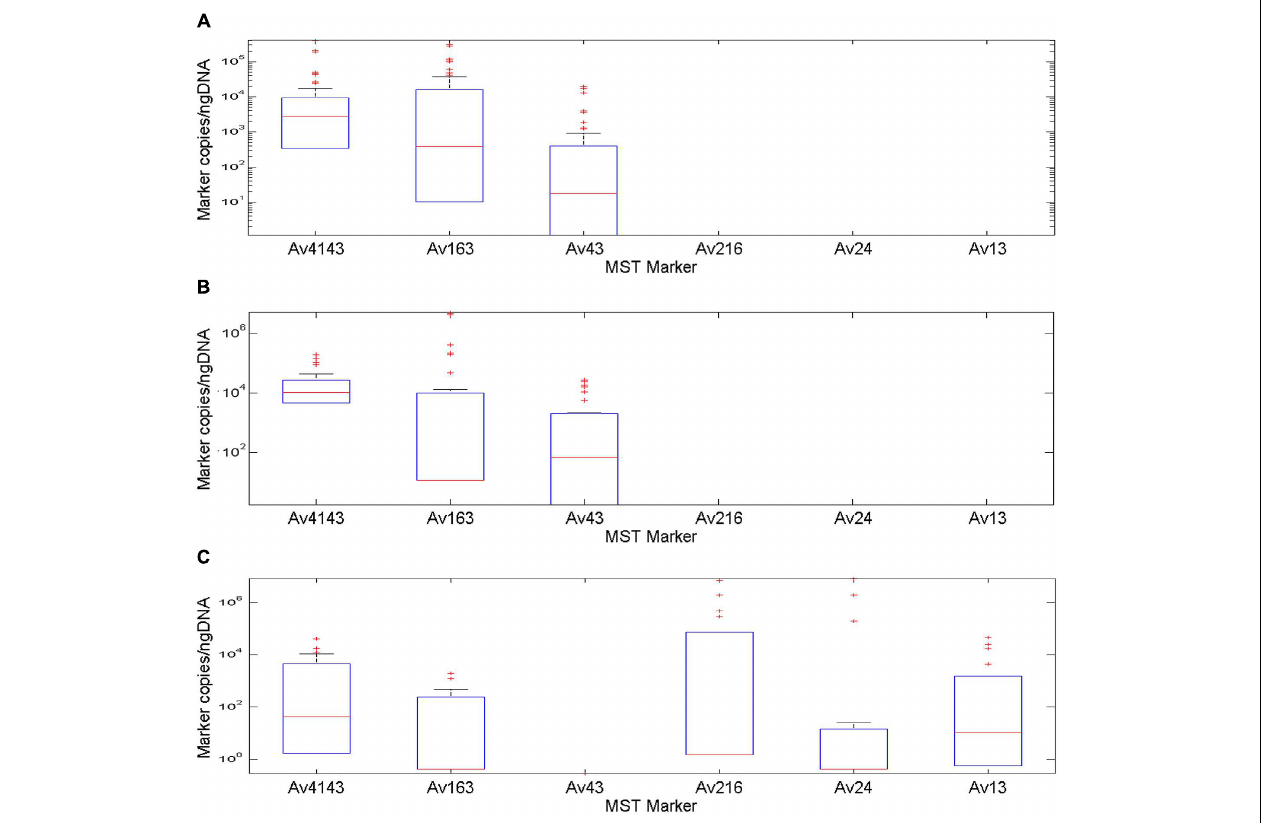
FIGURE 2 | A box plot diagram demonstrating copy number of MST markers Av4143, Av163, Av43, Av216, Av24, and Av13, identified in fecal samples collected from battery hens, poultry and waterfowls normalized to nano-grams of DNA. Boxes exhibit 25 and 75 percentiles, lines within boxes represent median values and plus signs identify outliers. (A) A marker profile pattern from fecal battery hens revealed occurrence of three different makers: two general avian markers, Av4143 and Av163, and the Av43 poultry and battery hen marker, which was identified at a lower rate. (B) The marker profile signature of poultry samples was very similar to that of battery hens. (C) An avian marker profile of the waterfowl group comprised five of the six tested markers: Av4143 and Av163, the general avian markers, were identified to a lower extent than they were in battery hens or in poultry. The other three markers showed a wide range of quantification scales.